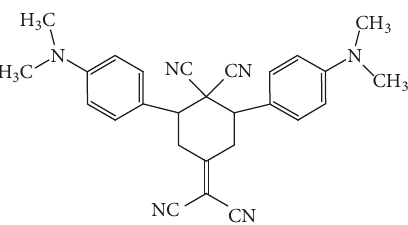
Figure 1: Chemical structure of 2,6-Bis(4-dimethylaminophenyl)-4-(dicyanomethylene)-cyclohex-ane-1,1-dicarbonitrile.